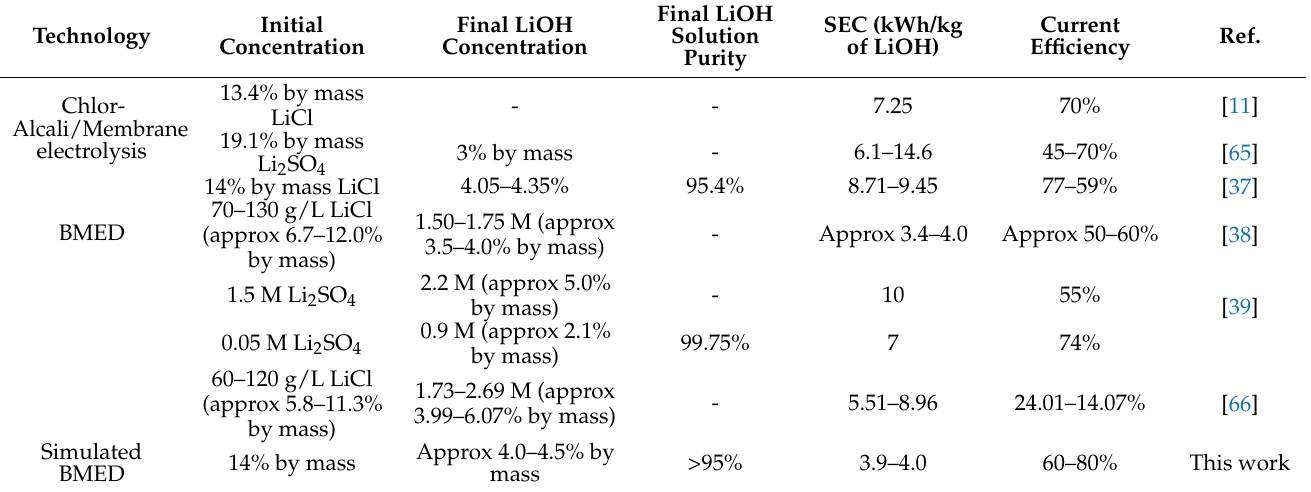
Table 5. Comparison of LiOH production yield results using Chlor-Alkali/Membrane electrolysis and BMED